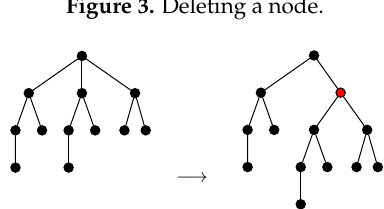
Figure 3. Deleting a node.